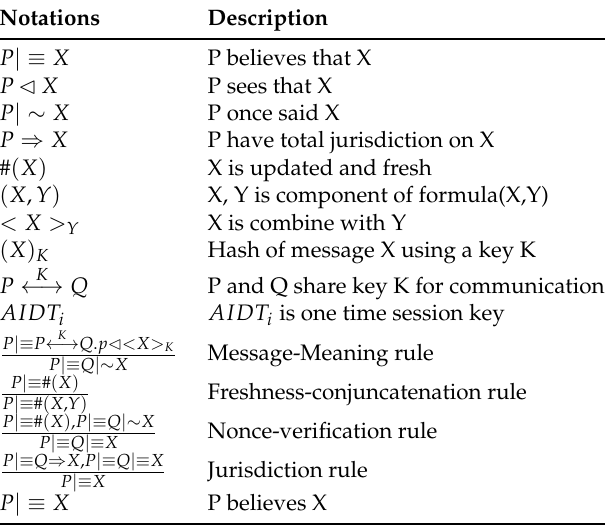
Table 3. BAN logic